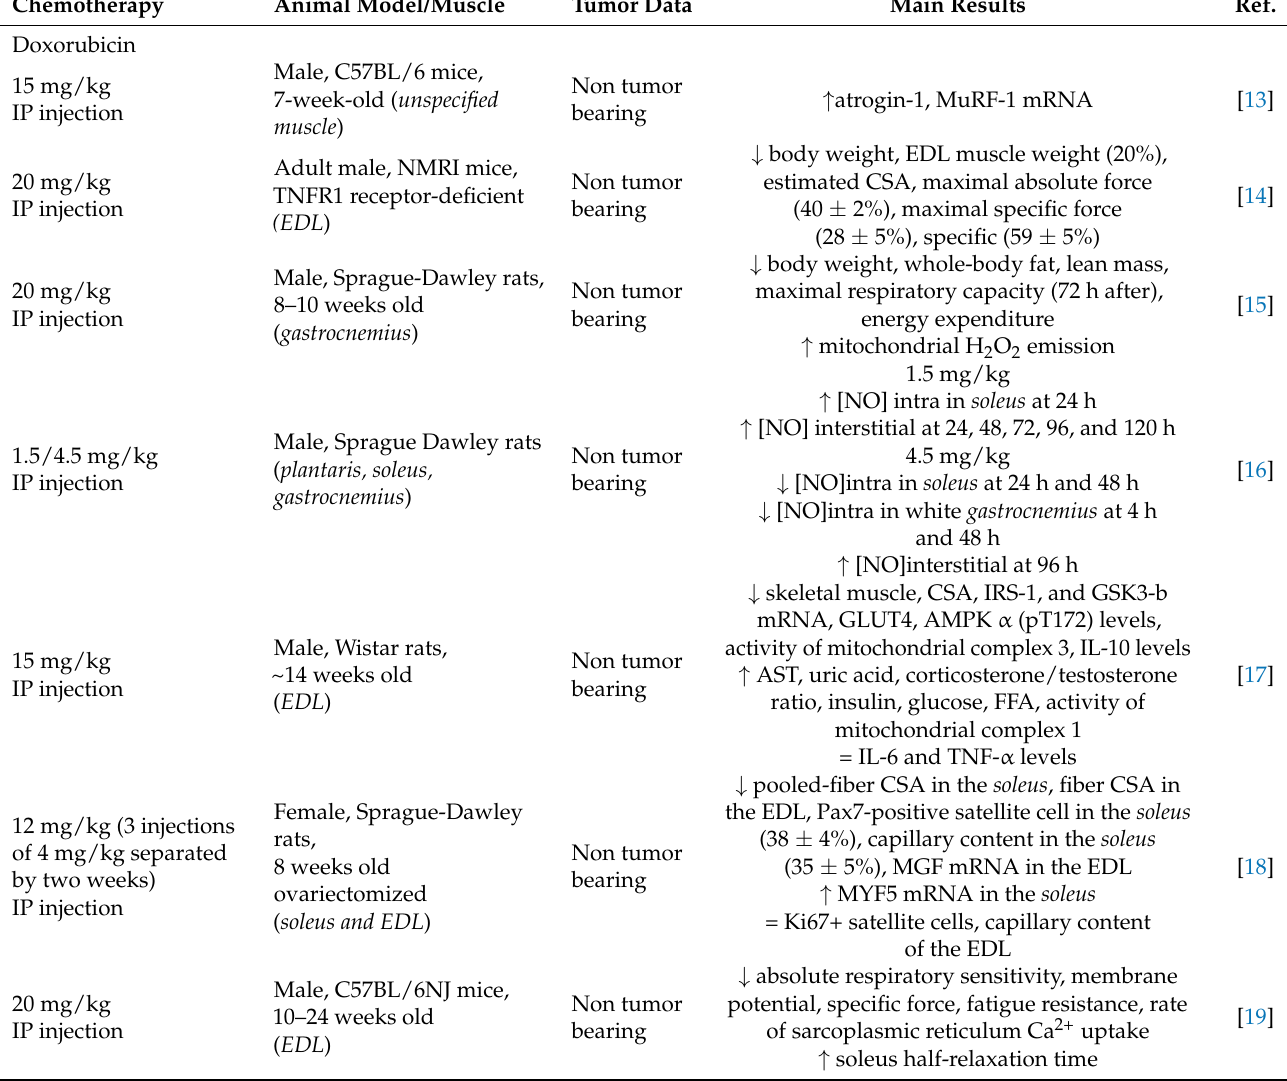
Table 1. Studies using animal models (mice and rats) to assess the effects of chemotherapy on SkM. Tumor Data Main Results